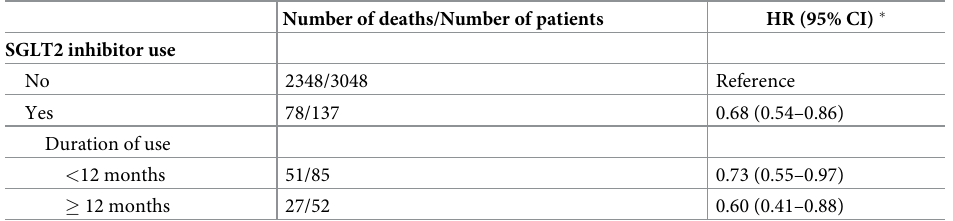
Table 2. Associations between sodium-glucose cotransporter 2 (SGLT2) inhibitor use and mortality among 3,185 hepatocellular carcinoma patients with T2DM.